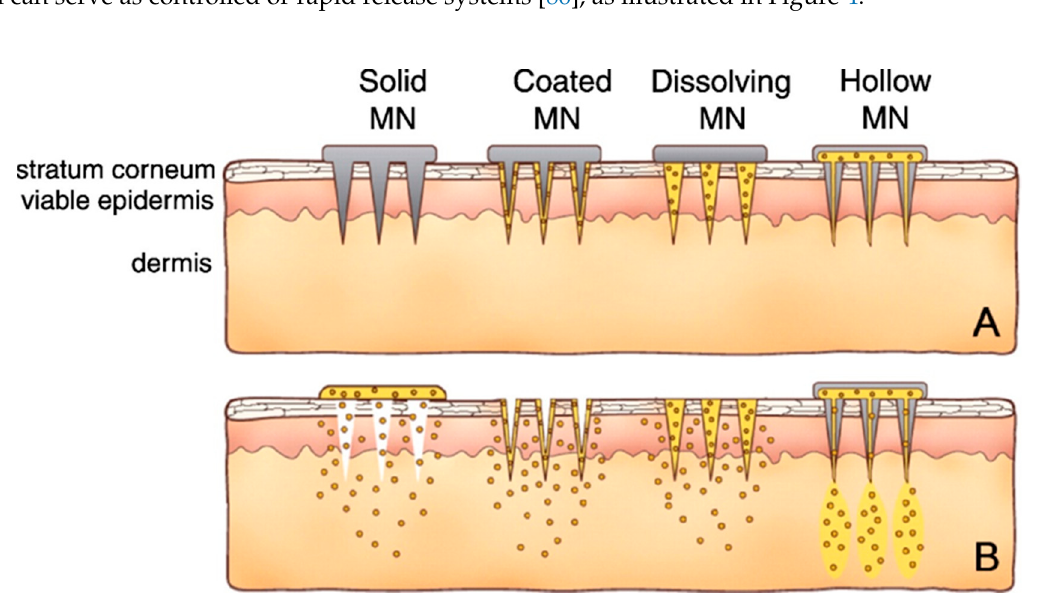
Figure 4. Methods of drug delivery to the skin using microneedles (MN)